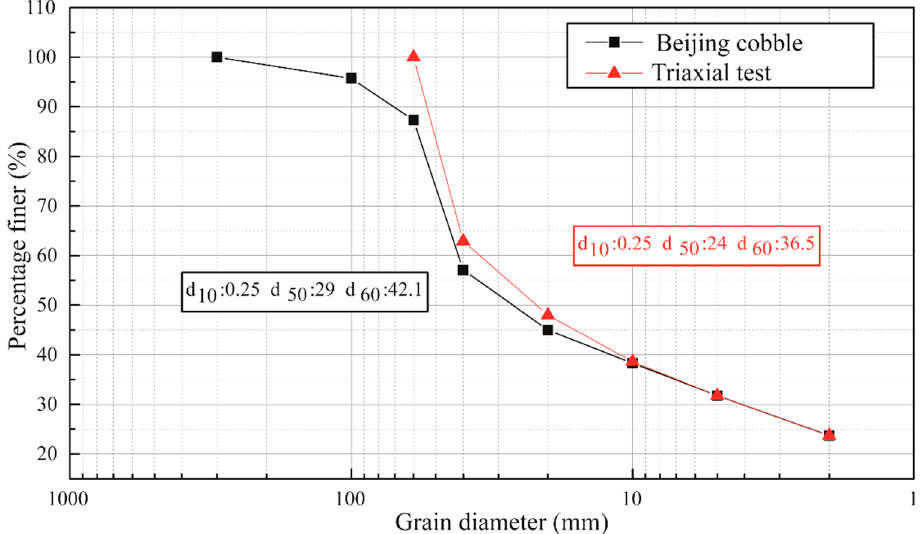
Figure 3. Grading curve of the in-situ soils and the sample used in the triaxial test (d is the maximum diameter of one single particle).